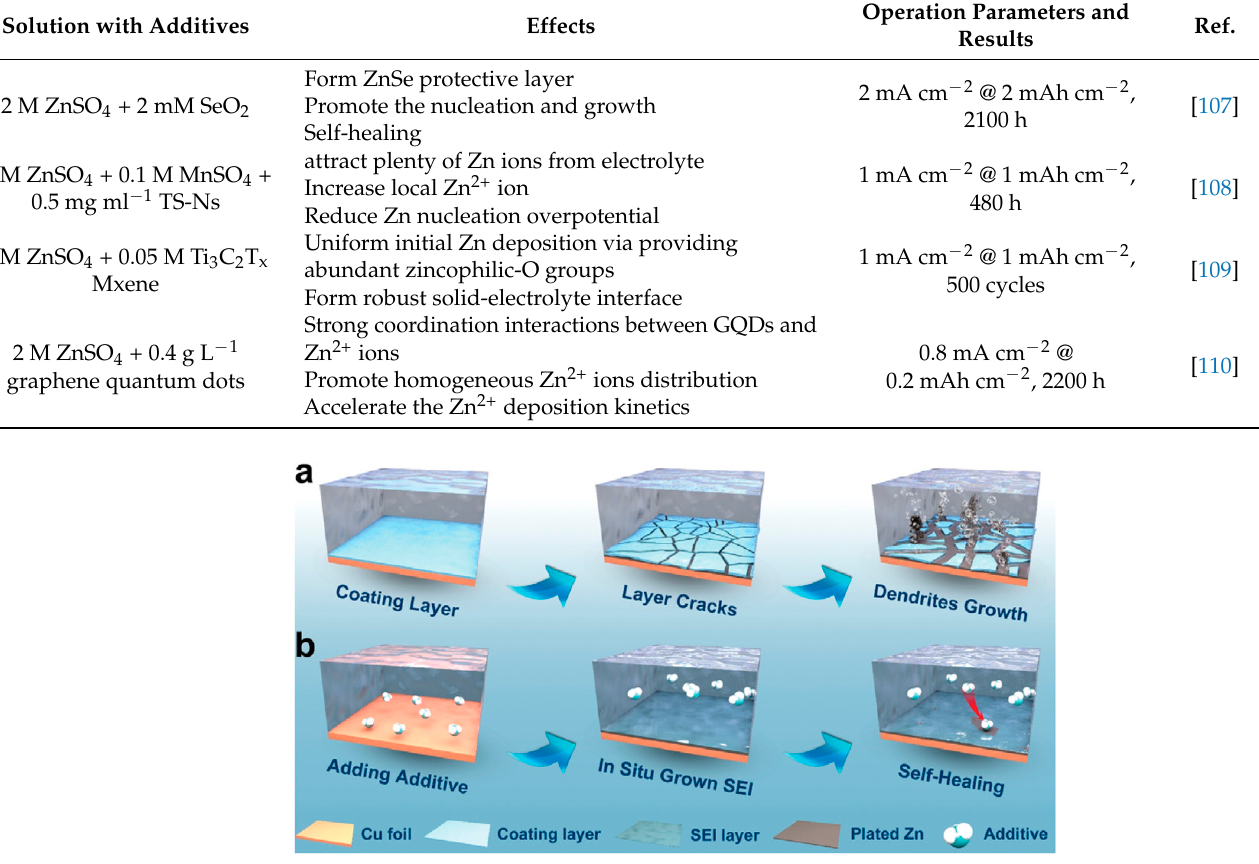
Figure 14. Schematic diagram showing Zn deposition using ( a ) coating layer and ( b ) SEI-forming additive strategy. Reproduced with permissions from Ref. [107]. Copyright © 2022 WILEY-VCH.